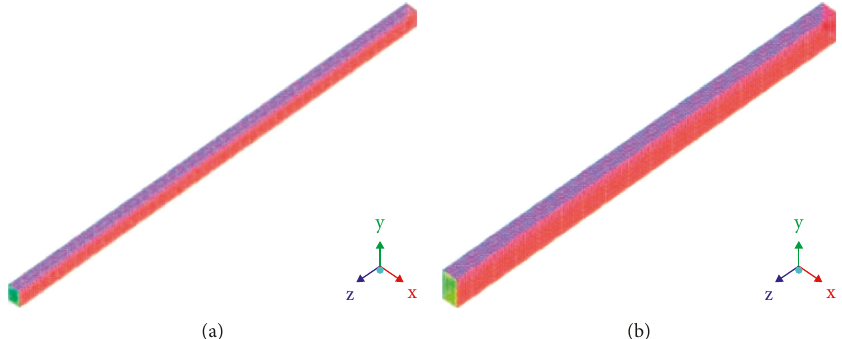
Figure 5: Global meshing of concrete of geopolymer beams with different sections. (a) 150mm